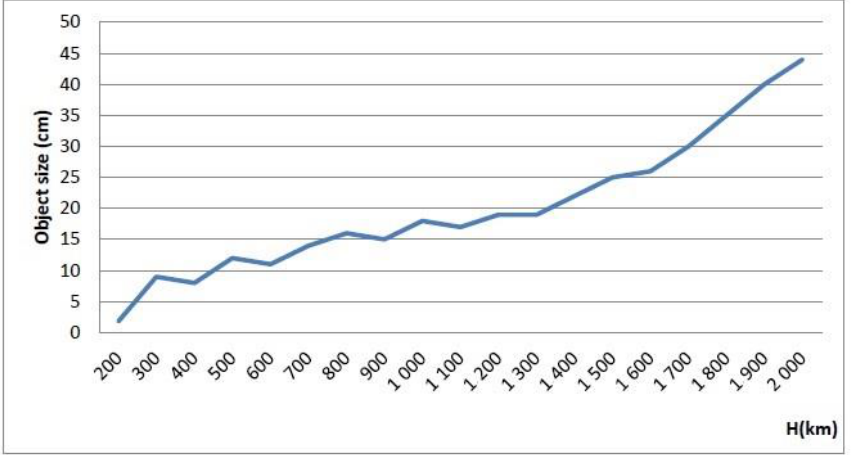
Figure 6. Minimum size of detectable targets according to the orbital altitude in CW mode [19].